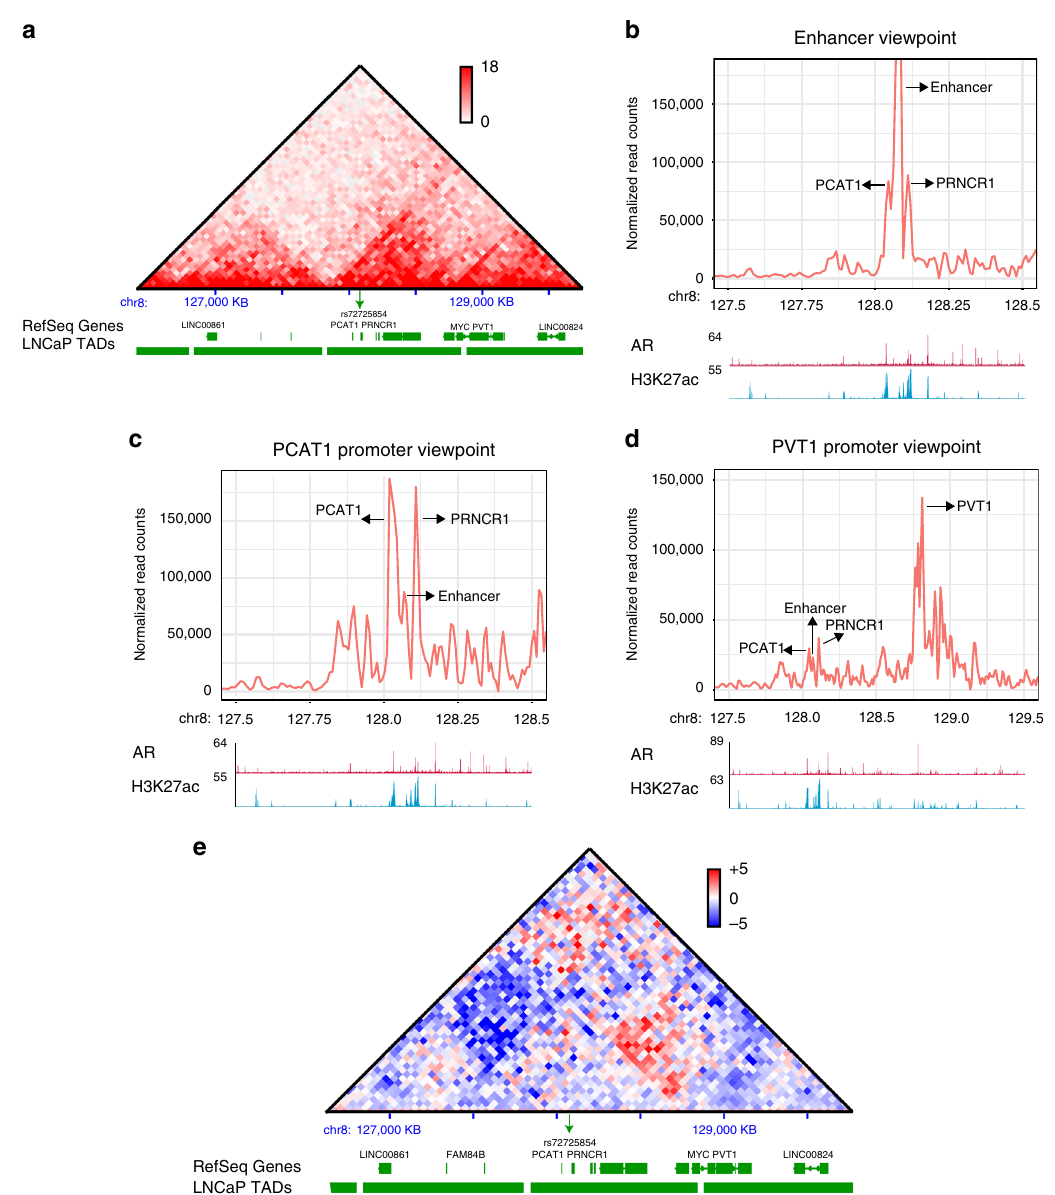
Fig. 3 The enhancer physically interacts with lncRNA promoters. a The TAD structure overlaid with gene annotations at the 8q24 region as seen from the HiC data in LNCaP cells. b Plots show 4C on the enhancer viewpoint using 4C-ker pipeline. c 4C plots from PCAT1 promoter viewpoint and d long- range interaction from 4C at PVT1 viewpoint, note the interactions marked by arrows. Tracks below the 4C plots in b – d show the ChIP-seq signal of AR and H3K27ac at the regions. e Comparative HiC in LNCaP and T47D showing the differential interactions at the 8q24 locus in the two cell lines. The red pixels show higher interactions in LNCaP and the blue ones show higher interactions in T47D, the heatmap is overlaid with gene annotations and TADs boundaries. 4C data are provided as source data fi